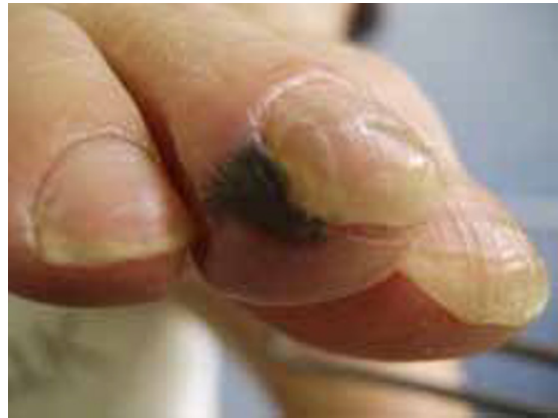
Figure 1. Necrotic lesion of the second toe of the right